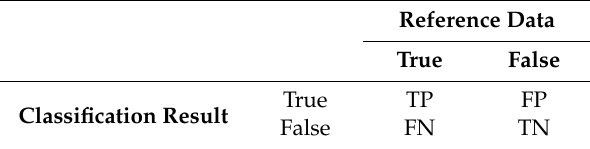
Table 2. Example binary confusion matrix and associated